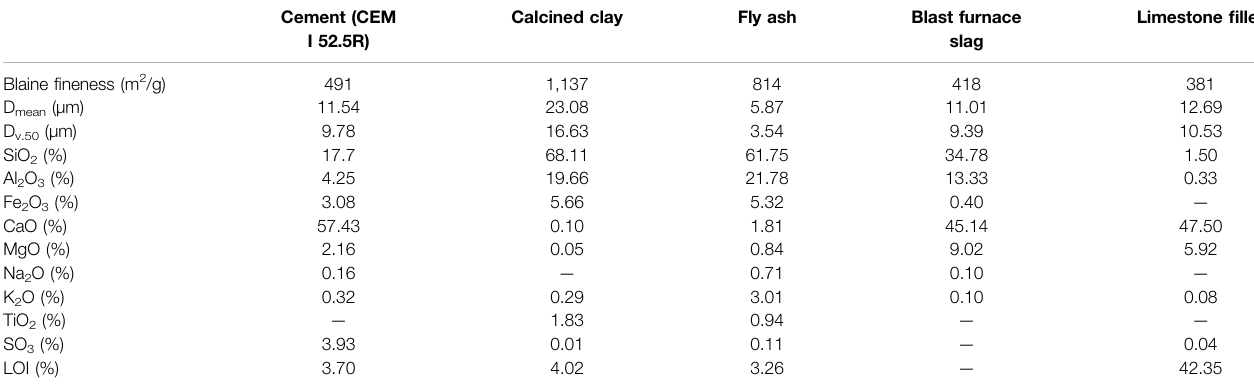
TABLE 1 | Chemical composition by FRX and physical characteristics of cement and